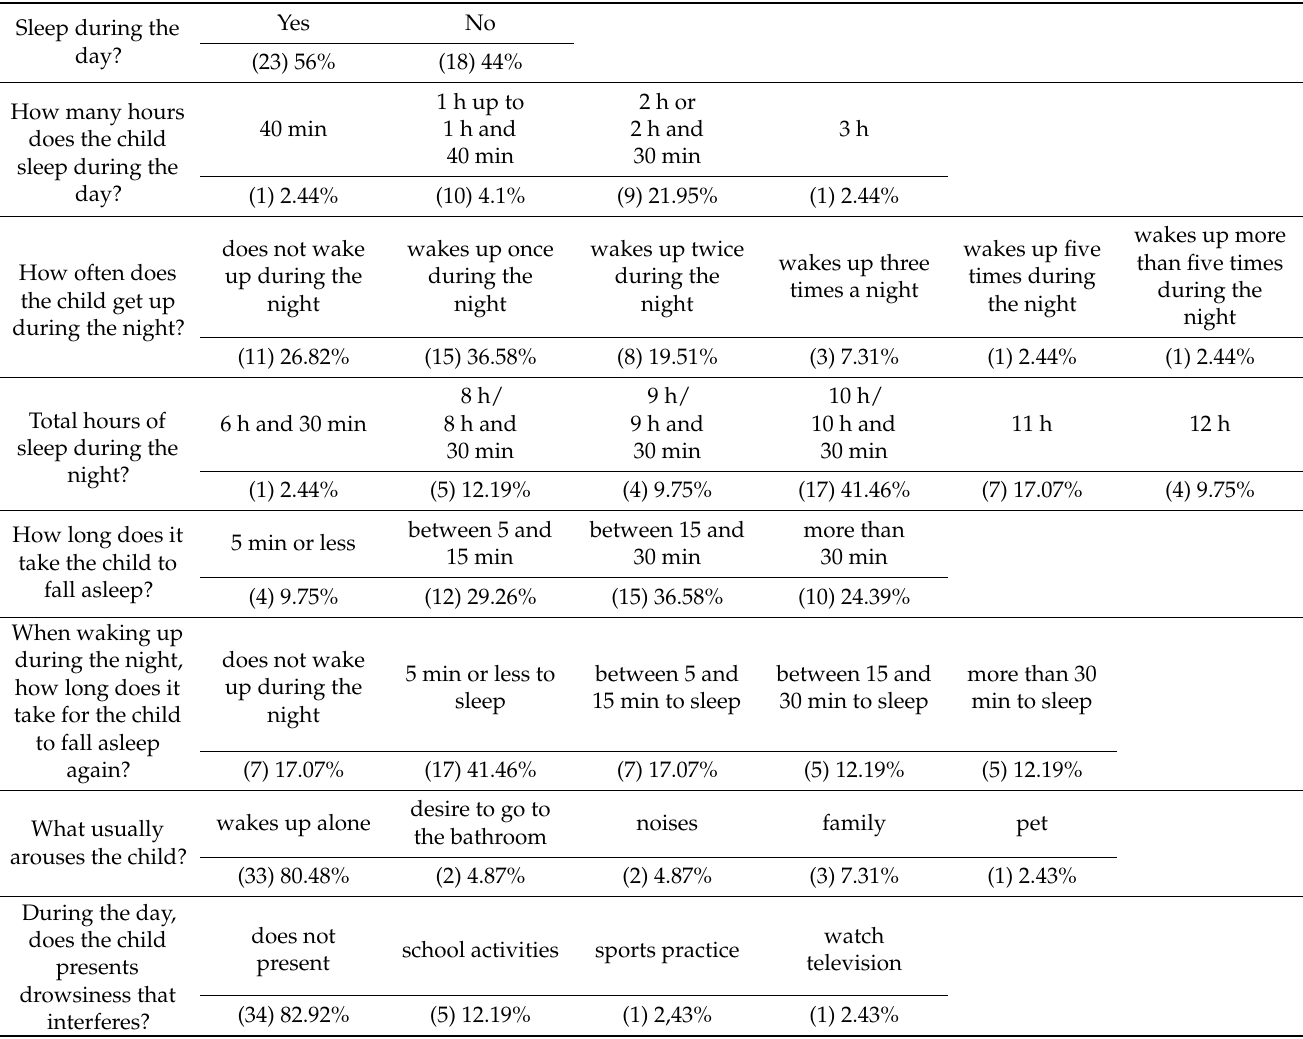
Table 2. Profile of the 41 Brazilian DS children and adolescents through the QRL.